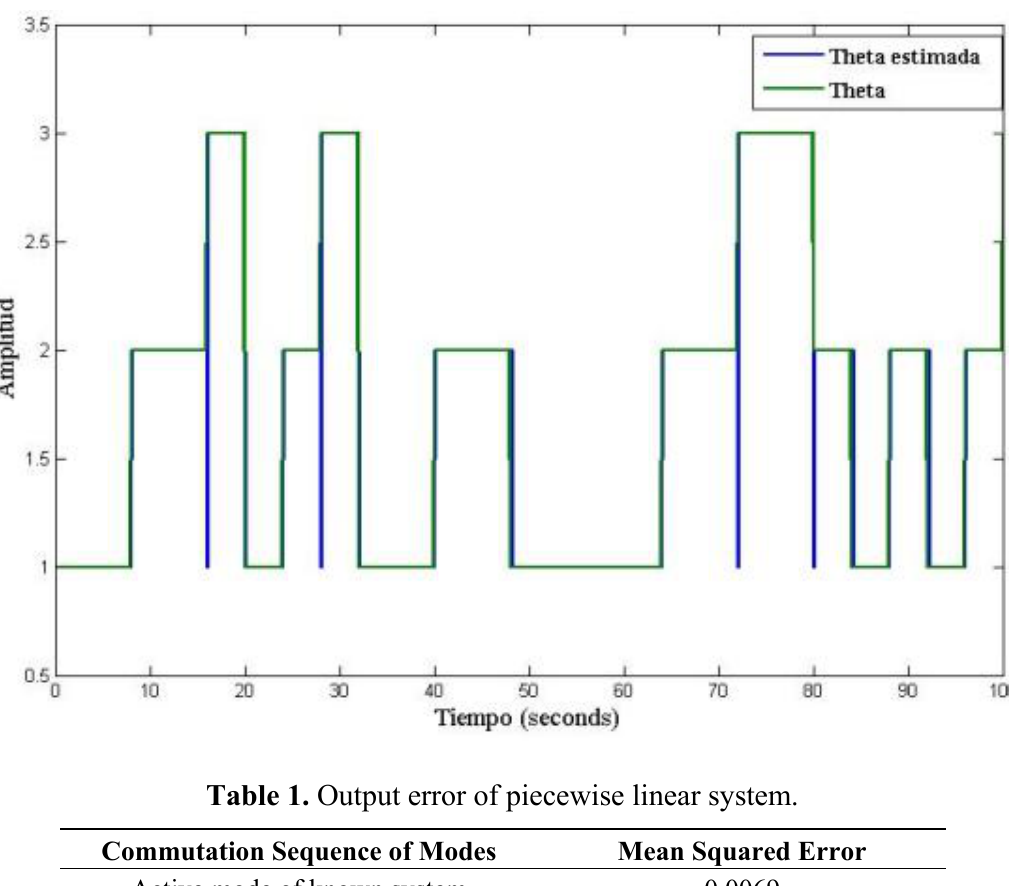
Figure 5. Commutation signal: estimated vs. real.